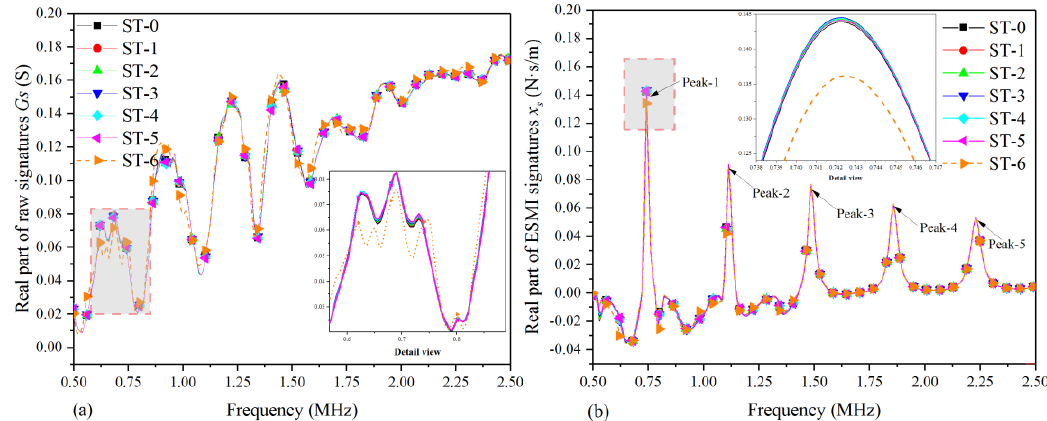
Figure 4. Real part plot of raw and effective structural mechanical impedance (ESMI) signatures: ( a ) G s ; ( b ) x s .